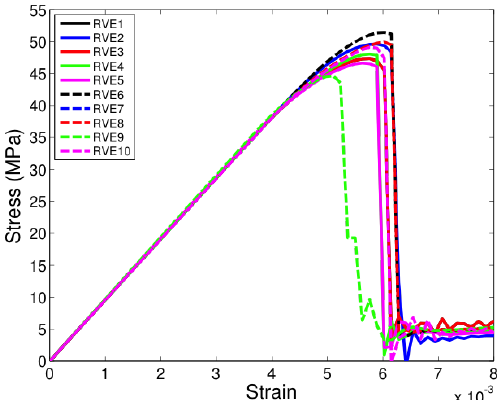
Figure 9. Transverse tensile response of six-fiber unit cells with V